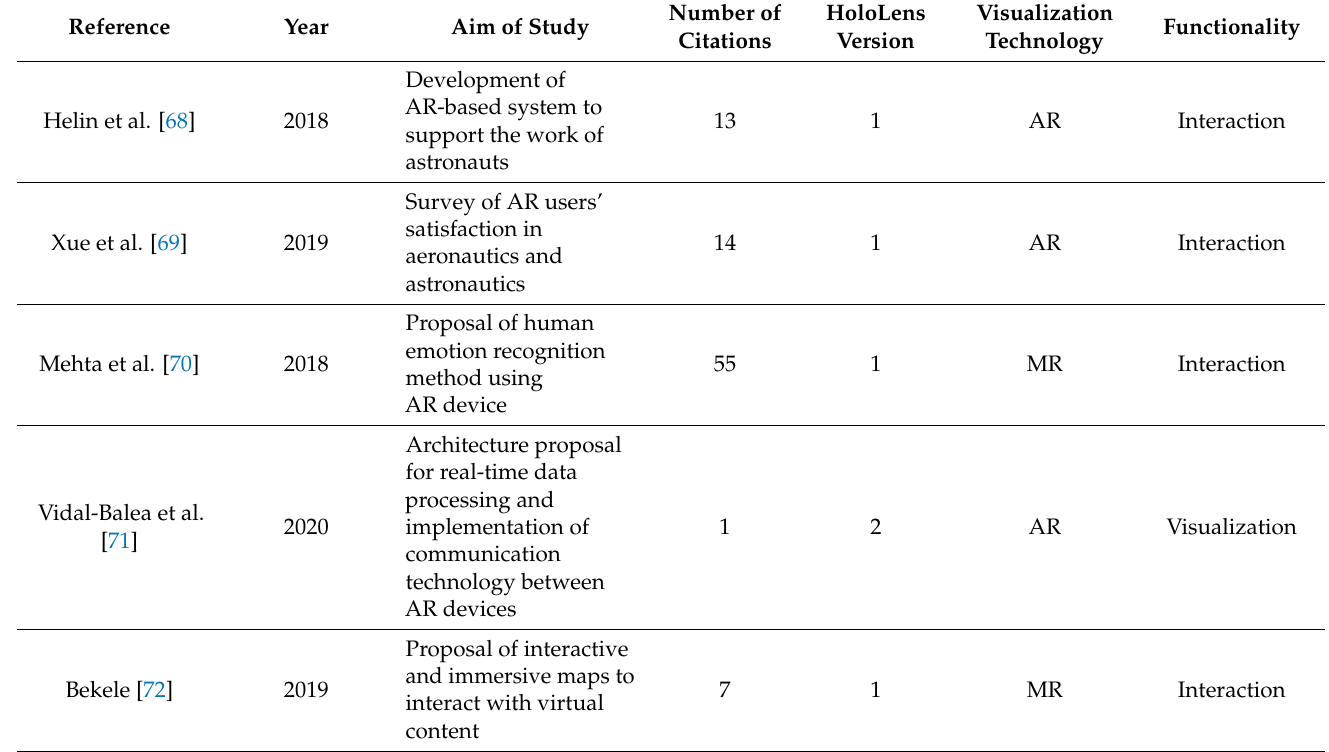
Table 6. Summary of the Microsoft HoloLens application for other